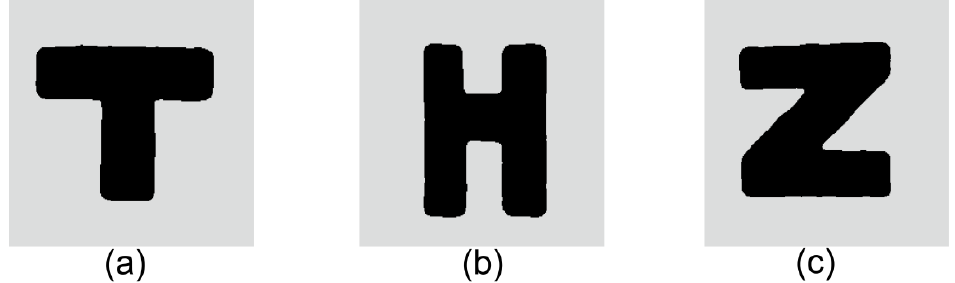
Figure 8. THz images of ( a ) sample 1, ( b ) sample 2, and ( c ) sample 3 obtained from the THz raster-scan imaging experiment.